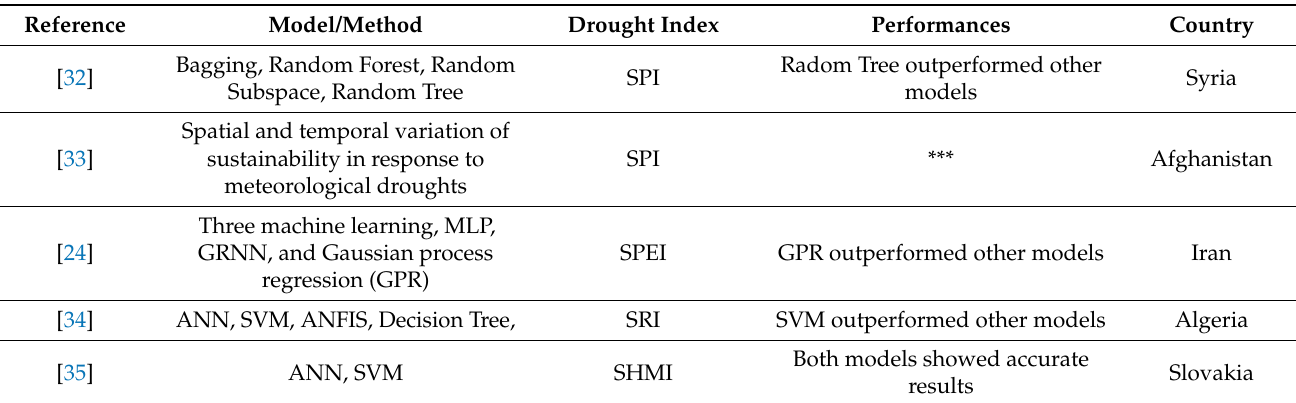
Table 1. Recent works of drought prediction using machine